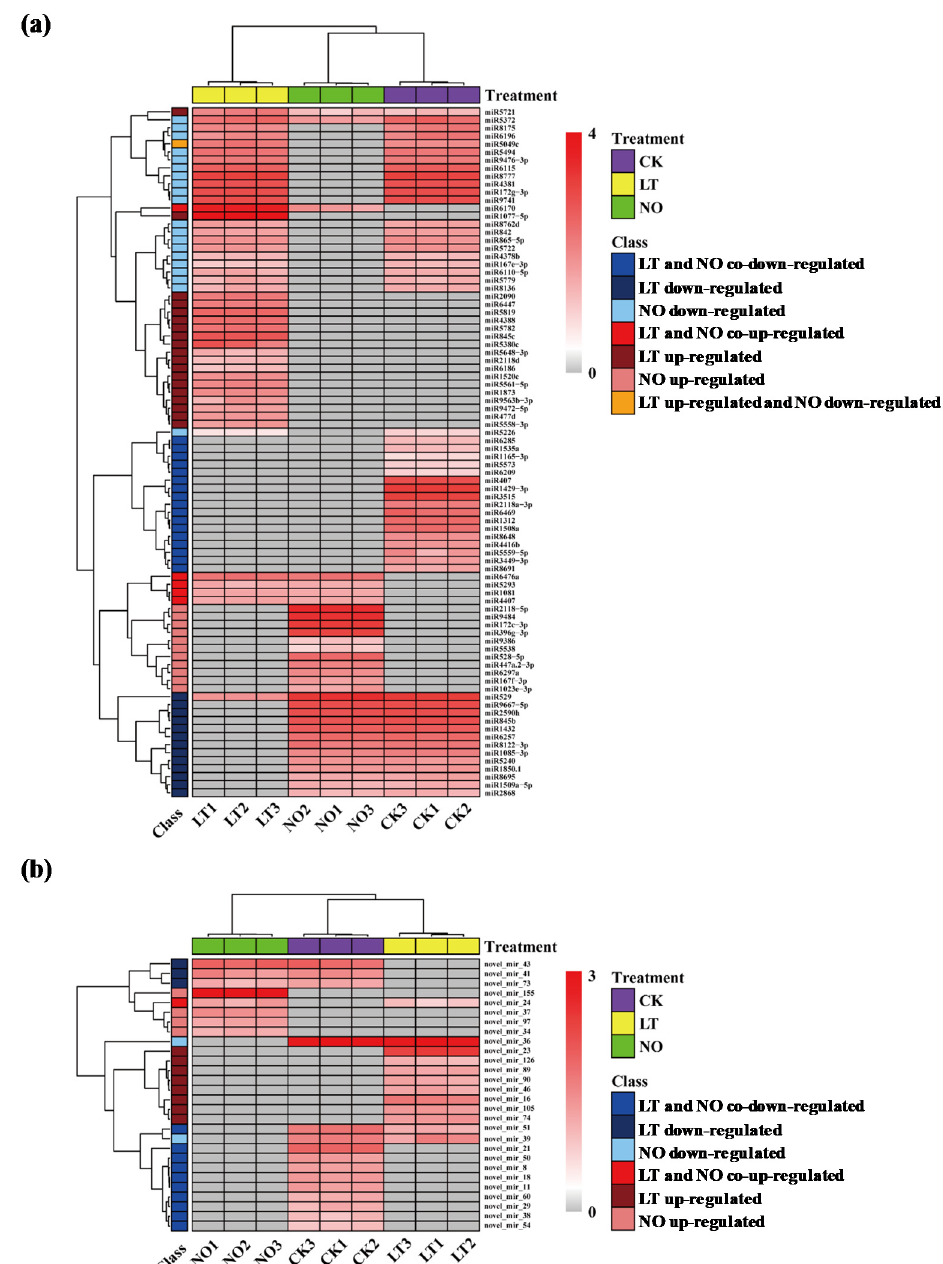
Figure 2. Hierarchical clustering analysis of known microRNAs (DEMs) ( a ) and novel miRNAs ( b ) expression in CK (control), LT (low-temperature) and NO (nitric oxide). CK1, CK2 and CK3; LT1, LT2 and LT3; NO1, NO2 and NO3 represent the three independent biological repetitions in CK, LT and NO, respectively. The gray square represents that the miRNA is not expressed in the sample. The cell colors from white to red represent the expression level of miRNA from low to high, and the value representing the cell color is the expression level of miRNA.